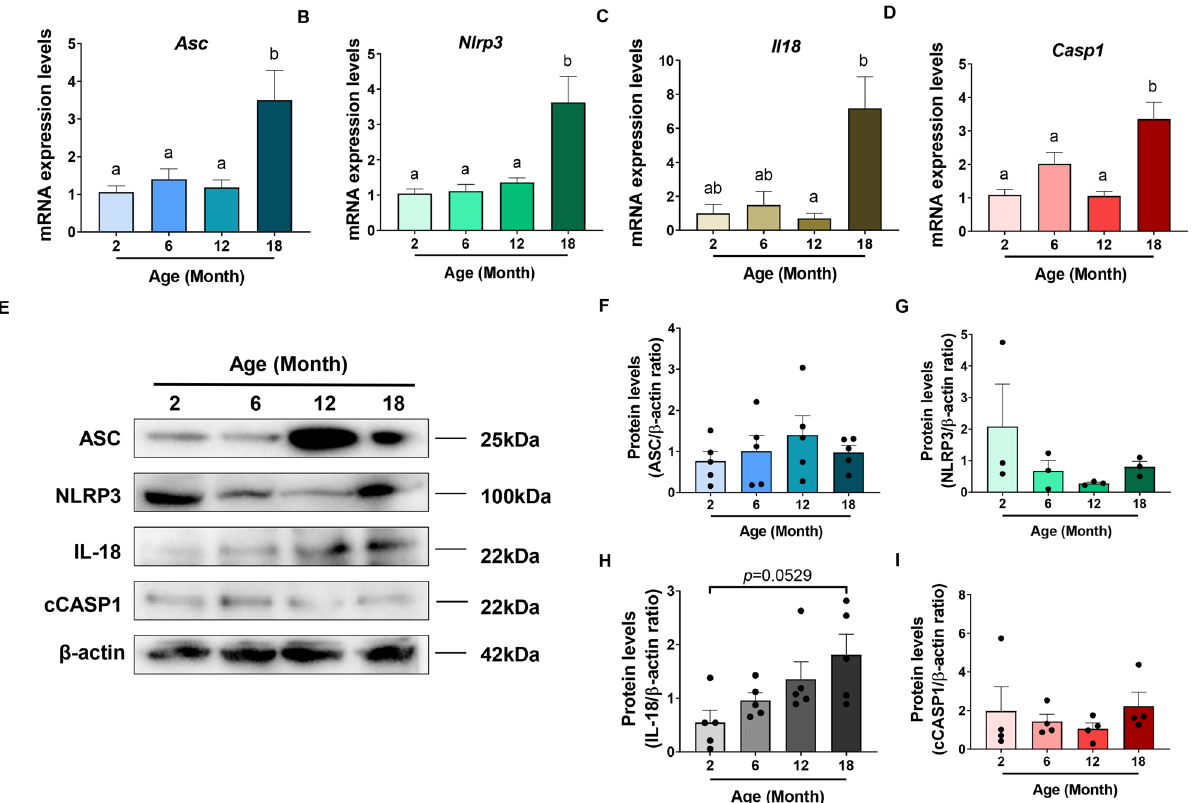
Figure 4. Reproductive ageing is accompanied by an increase in the intra-ovarian expression of inflammatory cytokines. Gene expression levels of inflammasome-related genes Asc ( A ), Nlrp3 ( B ), Il18 ( C ) and Caspase1 (Casp1) ( D ) in ovaries from 2, 6, 12 and 18-month-old mice. n = 6 per cohort. Data are presented as mean ± SEM; ( A , B , D ): Ordinary One-way ANOVA, Tukey’s multiple comparisons test: a and b are significantly different among groups ( p < 0.05). ( C ): Kruskal–Wallis test, Dunn’s multiple comparisons test: a and b are significantly different among groups ( p < 0.05). ( E ) Representative image of a Western blot showing ovarian protein levels of ASC, NLRP3, IL-18 and cleaved Casp1 (cCASP1) from 2, 6, 12 and 18-month-old mice. Quantification of protein levels of ASC ( F ), NLRP3 ( G ), IL-18 ( H ) and cCASP1 ( I ) in ovaries from 2, 6, 12 and 18-month-old mice. n = 3–5 per cohort. Data are presented as mean ± SEM; E, F, Ordinary One-way ANOVA, Tukey’s multiple comparisons test ( p > 0.05). ( G , H ); Kruskal–Wallis test, Dunn’s multiple comparisons test ( p > 0.05). Each dot represents one